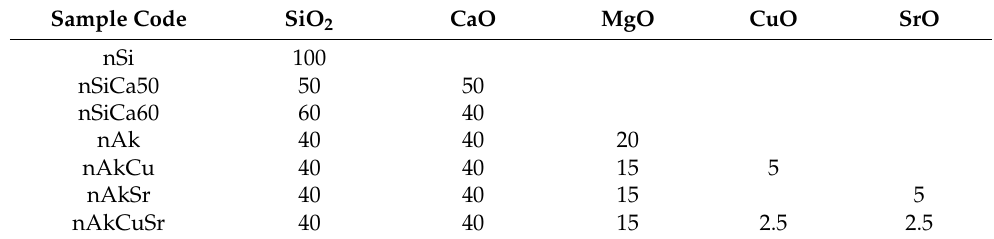
Table 1. Compositions of NPs in